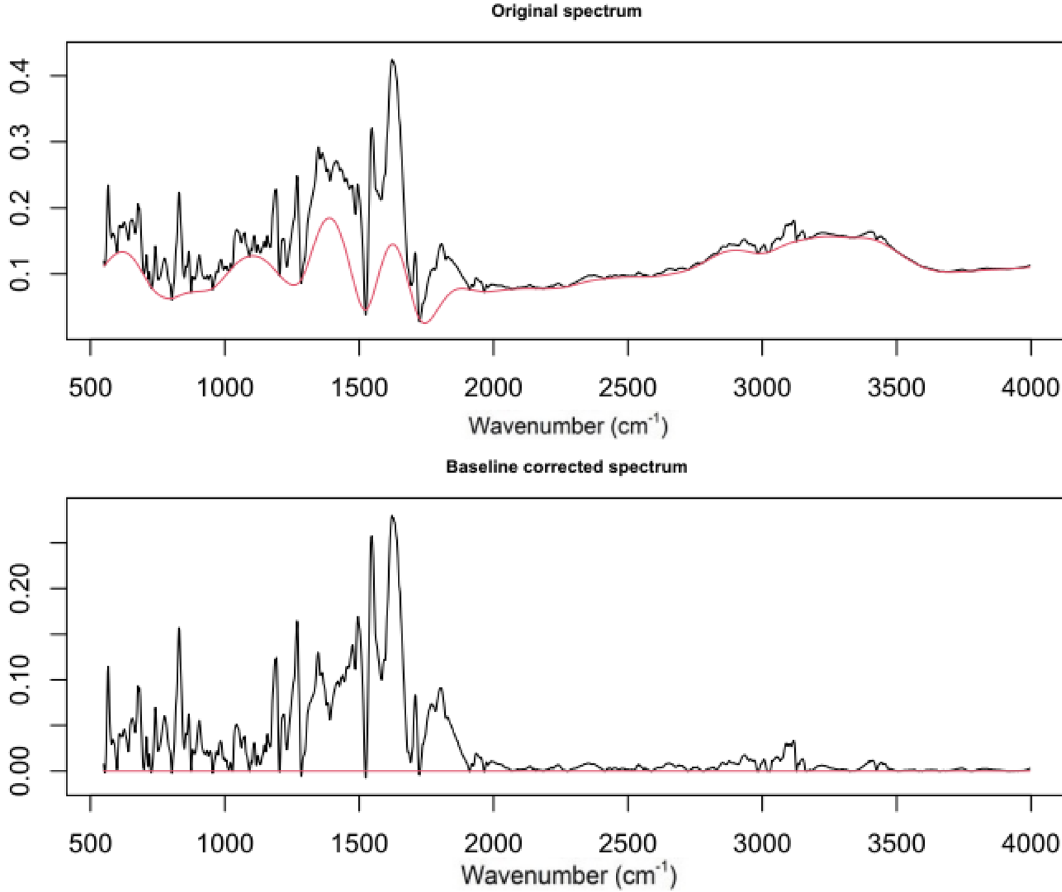
Figure 2. A comparison of initial and baseline corrected spectral data for complexes is shown below. With the smoothing parameter, ALS corrects the baseline for S. aureus (cid:31) = 4.100 and wights p = 0.001 .